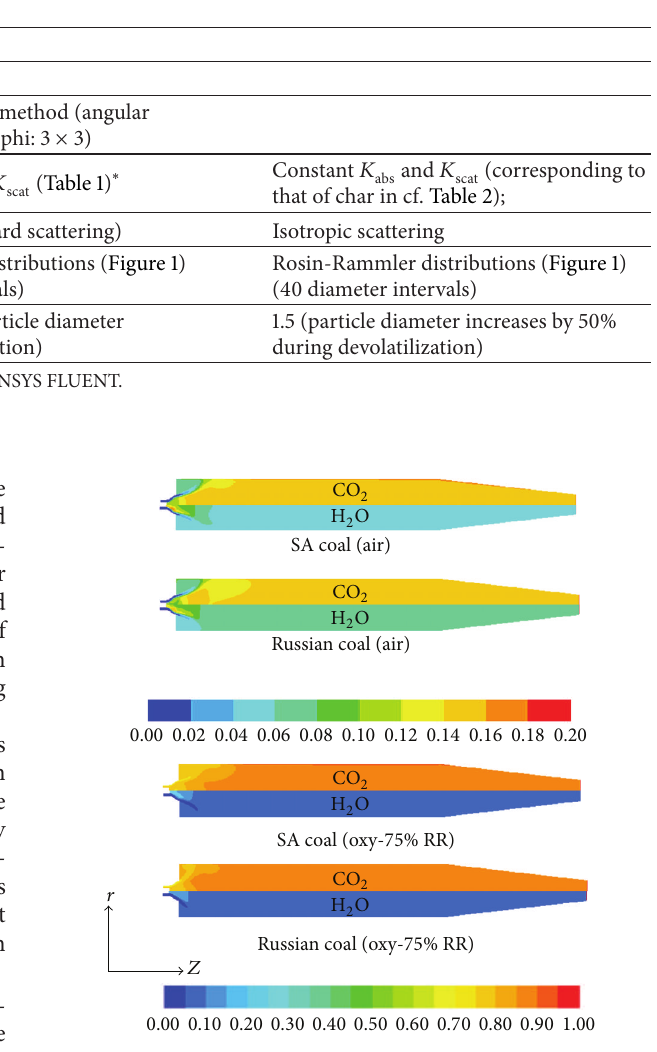
Figure 3: Contours of CO 2 and H 2 O mole fractions during the combustion of Russian and SA coal in air and in the oxy-75% RR scenario (varying particle radiative